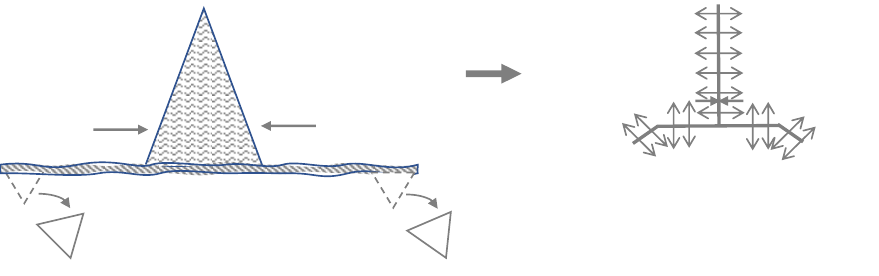
Figure 3. A schematic view on the A-T plasty.